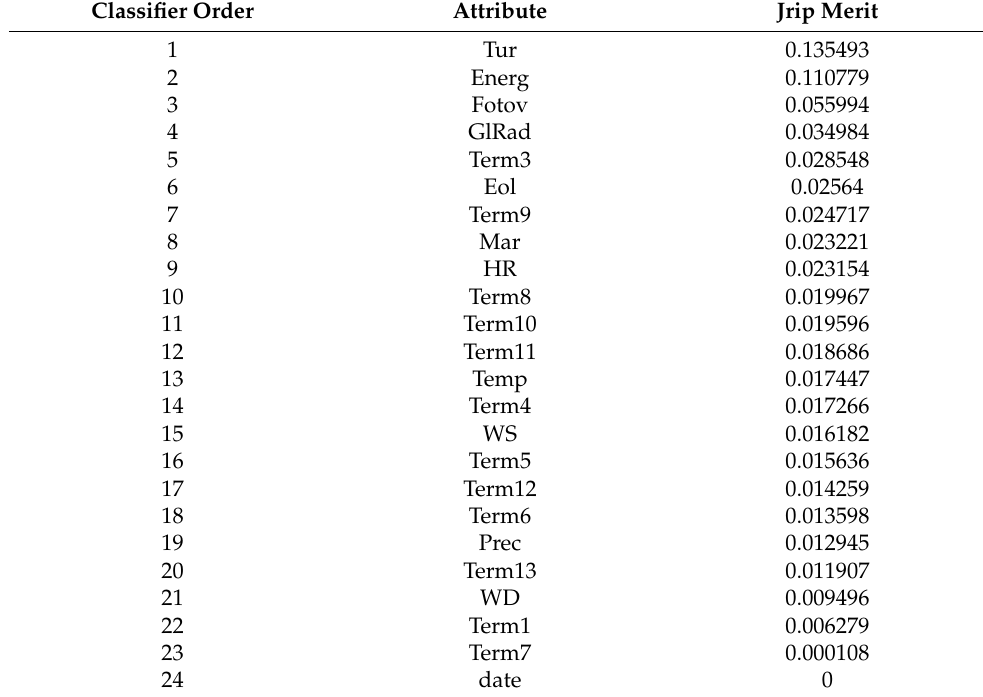
Table 7. Attribute classification evaluator classifier attribute Jrip.